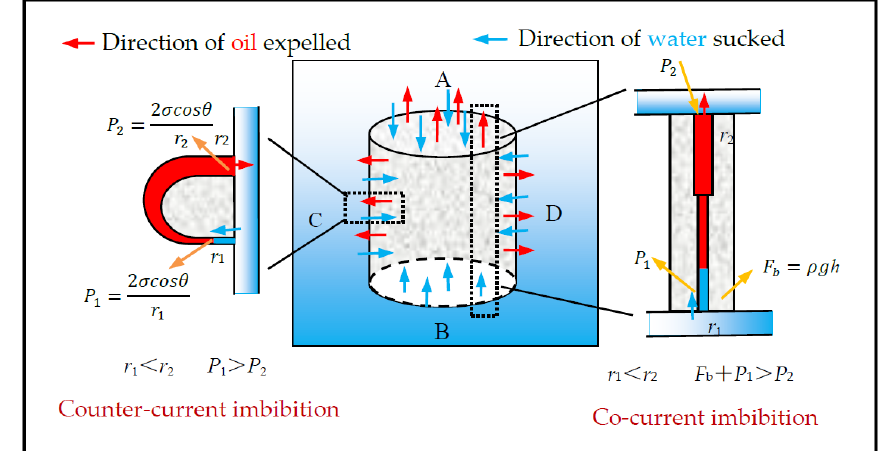
Figure 9. MRI of core for SI tests.